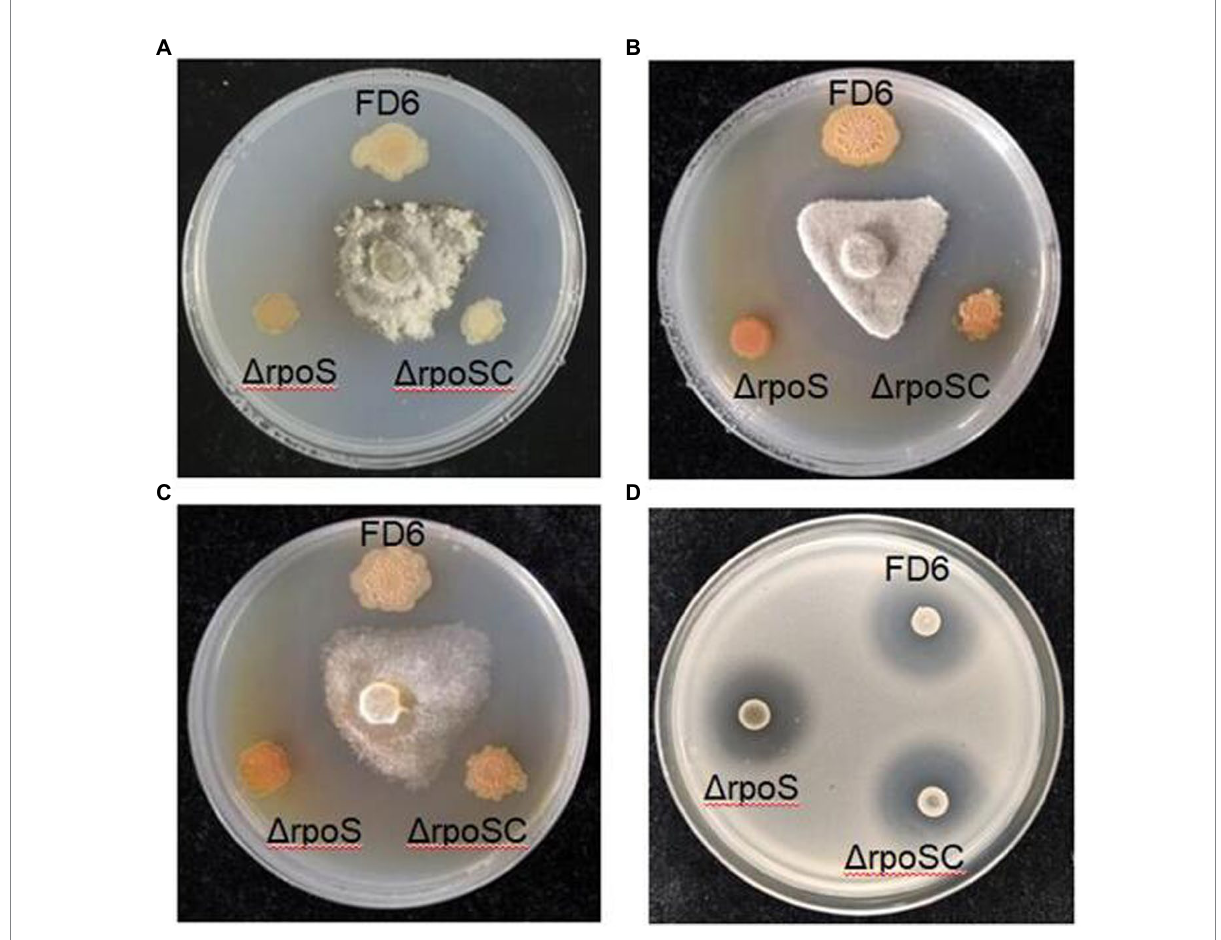
FIGURE 2 Effect of RpoS on the antagonistic ability of P. protegens FD6 against (A) Botrytis cinerea , (B) Monilinia fructicola , (C) Phytophthora capsici and (D) Ralstonia solanacearum . The antifungal abilities of FD6 and its derivatives were determined by measuring the inhibition zone of these phytopathogenic fungi on PSA plates. The antibacterial activities of FD6 and its derivatives against R. solanacearum were assessed on TM plates. The experiment was performed in three biological